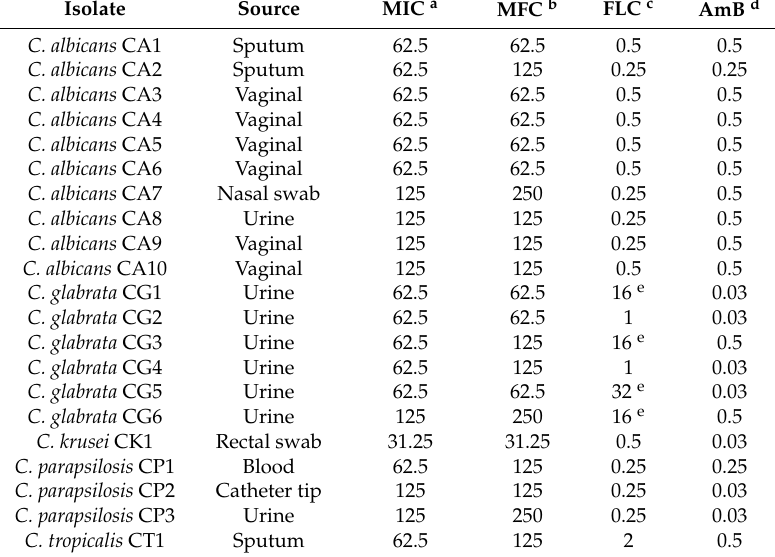
Table 2. Anti- Candida activity of the complex 1 [CuCl 2 (Bipy)(L 1 )] in planktonic cells by microdilution in broth technique (µg/mL).